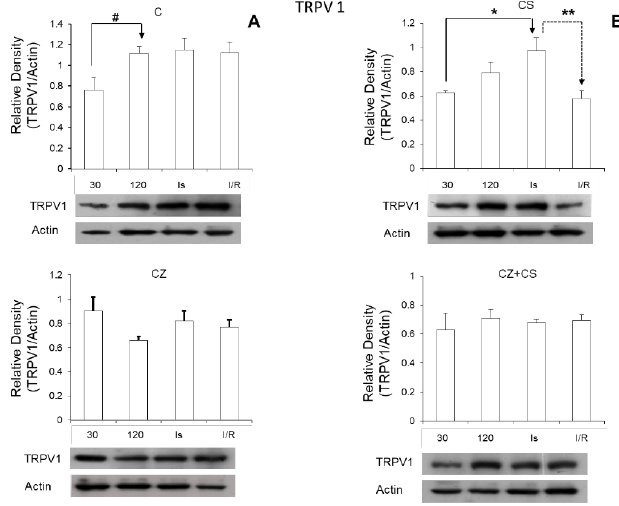
Figure 7. Levels of TRPV1 increased with the perfusion time (120 min) and with ischemia and reperfusion in the control group (A) . Treatment with CS significantly increased the levels of TRPV1 during ischemia and the level remained at the baseline during reperfusion (B) . Treatments with CZ and with the combination CZ+CS did not show changes in the levels of TRPV1 Values are the mean ± SE ( n = 5 in each group p ≤ 0.05). # C (30min vs. 120 min); * CS (30 min vs. ischemia); ** CS (ischemia vs. I/R).